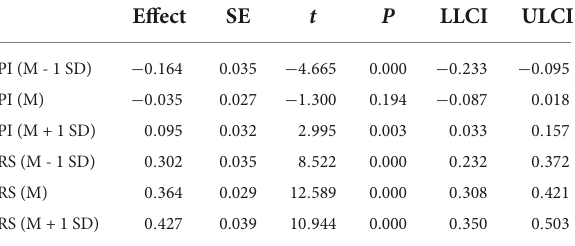
TABLE 5 Moderating effect on different moderated levels of PI and RS.